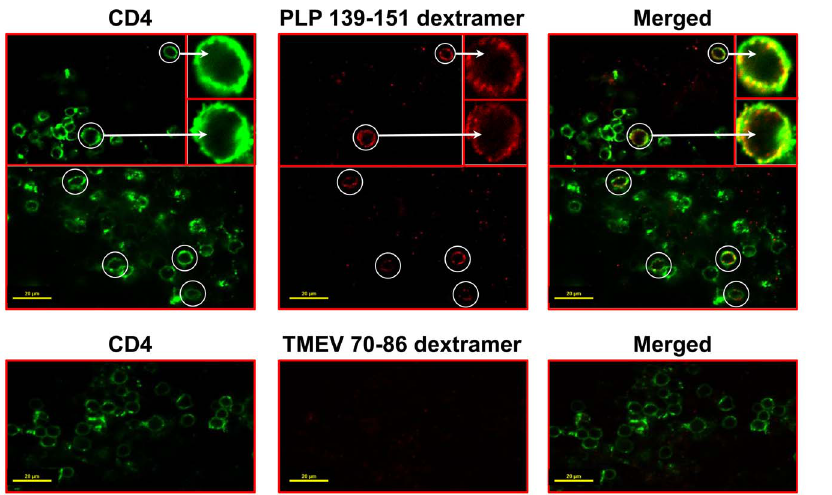
Figure 2. Detection of PLP-specific T cells by insitu staining with PLP 139–151 dextramers. EAE was induced in SJL mice by immunizing the animals with PLP 139–151 in CFA. At termination, cerebrums collected from EAE mice were embedded in 4% agarose, and the sections were made using vibratome. After staining with cocktails containing either PLP 139–151 dextramers/anti-CD4 or TMEV 70–86 dextramers (control)/anti- CD4 and fixing with 4% PBS-buffered paraformaldehyde, sections were washed and mounted for examination by LSCM. Top panels: sections stained with PLP 139–151 dextramers and anti-CD4. Bottom panels: sections stained with TMEV 70–86 dextramers and anti-CD4. Left panel: CD4, green; Middle panel: dextramers, red; Right panel: merged (circles, dext + CD4 + T cells; insets represent enlarged views of dext + CD4 + T cells). Original